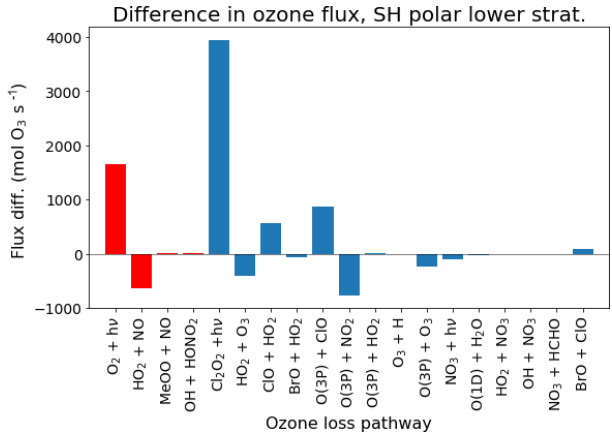
Figure 9. Annual difference in ozone production (red)/destruction (blue) flux between “new het.” and control runs, in the lower strato- sphere (12–24km) south of 65 ◦ S (1996–2009).